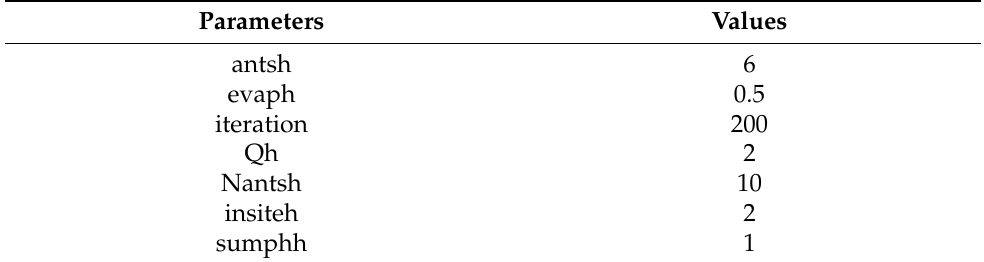
Table 3. Parameters of the Hybrid Genetic Ant Colony Optimization (HGACO)